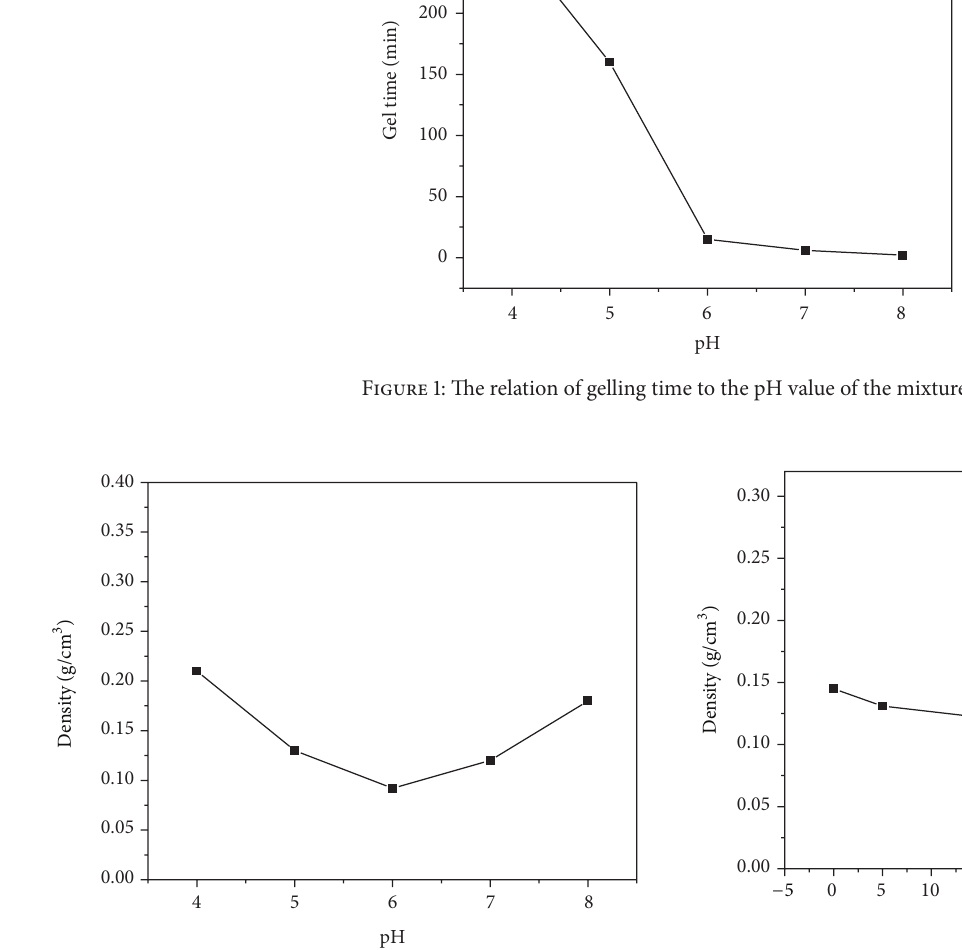
Figure 3: The relation of aerogel density to the TEOS concentration in aging